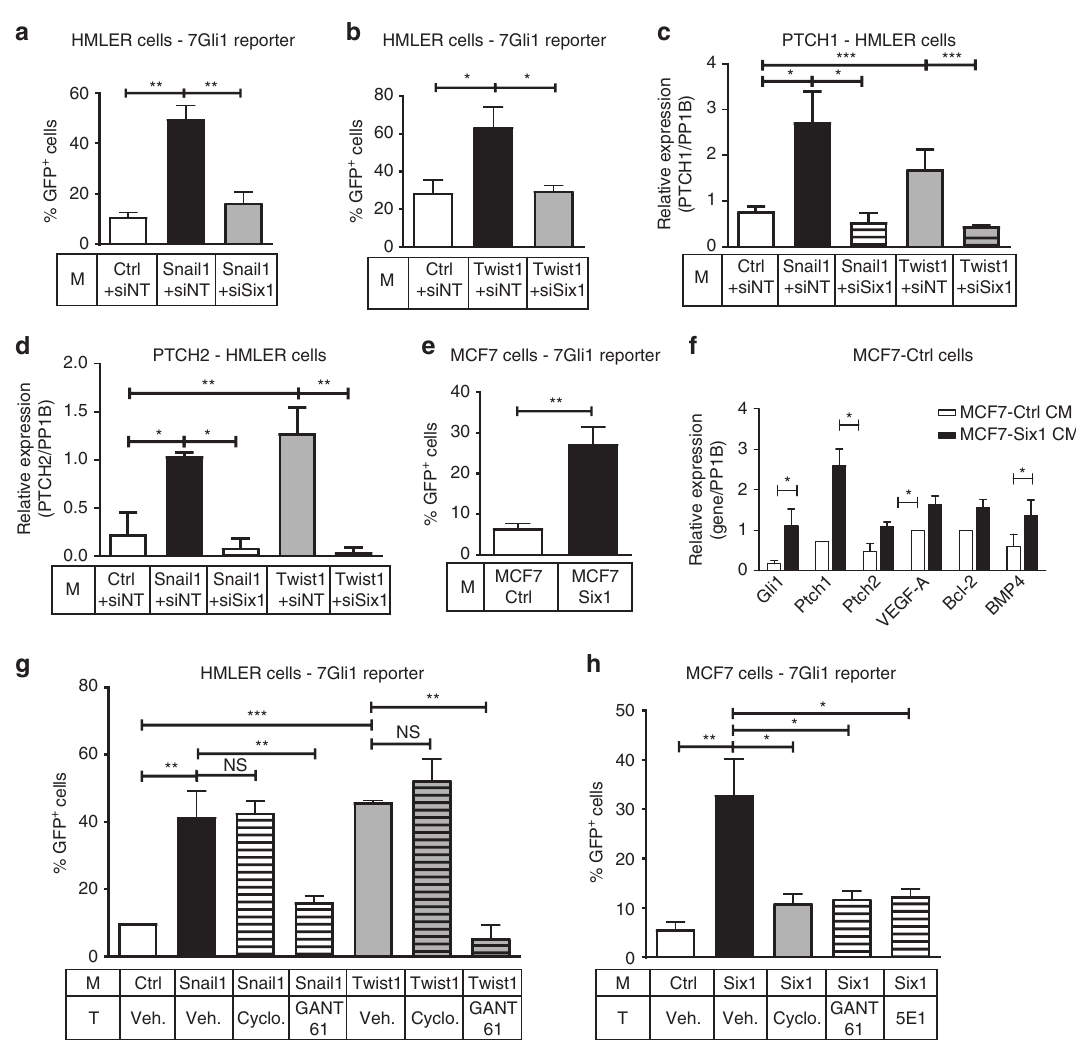
Figure 4 | Hh/GLI signalling is activated canonically and non-canonically downstream of EMT-TFs. 7-Gli1 reporter assays performed in ( a , b ) HMLER-Ctrl cells treated with CM from HMLER-Ctrl cells or from HMLER-Snail1/Twist1 cells ± siSix1. ( c , d ) Quantitative real-time PCR (qRT–PCR) analyses of Hh pathway target genes in HMLER-Ctrl cells cultured in indicated CM. ( e ) 7-Gli1 reporter assays in MCF7-Ctrl cells cultured in MCF7-Ctrl or Six1 CM. ( f ) qRT–PCR analyses of Hh pathway target genes in MCF7-Ctrl cells cultured in indicated CM. ( g , h ) 7-Gli1 reporter assays of ( g ) HMLER cells cultured in CM from HMLER-Ctrl, Snail1 and Twist1 cells, and ( h ) MCF7-Ctrl cells cultured in MCF7-Ctrl/Six1 CM and treated with vehicle (Veh.), 10 m M cyclopamine, 10 m M GANT61, or 3–5 m gml (cid:2) 1 of 5E1 monoclonal antibody. Gene expression is normalized to PP1B; all Gli1-GFP assays represented as %GFP þ cells. M, Media; T, Treatment; s.e.m. shown, n Z 3, except for c , d , f using different sets of CM where n Z 2. One-way ANOVA with Tukey’s post test for ( a – d , g , h ) and two tailed unpaired t -test for ( e , f ). NS, not significant; * P o 0.05, ** P o 0.01 and *** P o 0.001.